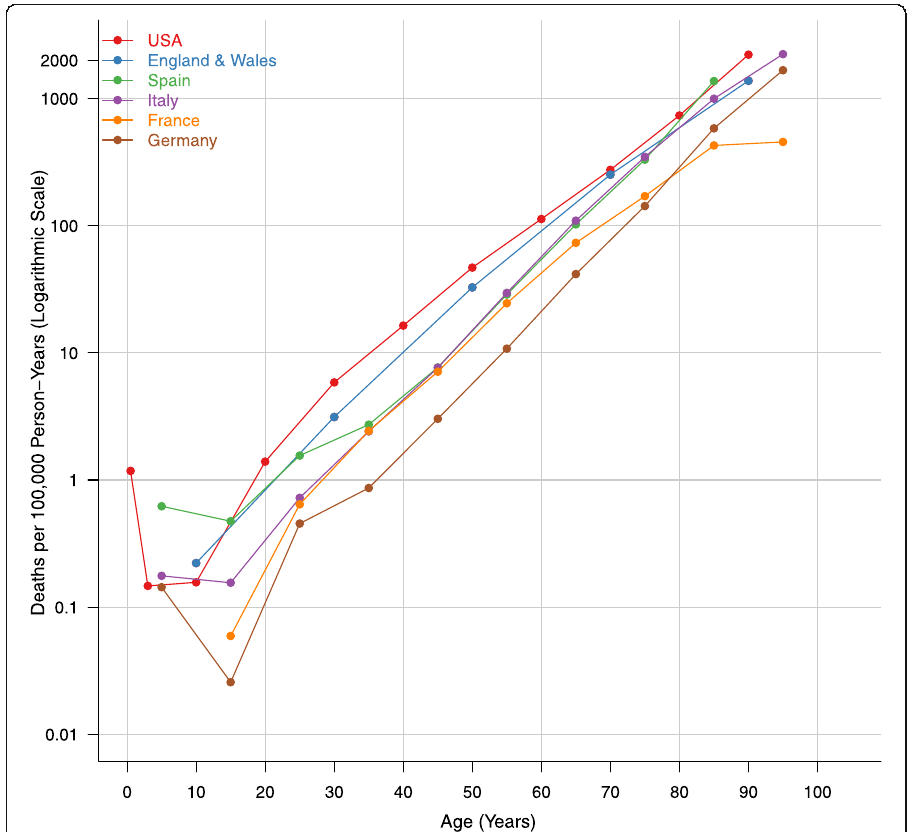
Fig. 1 Age-specific death rates from COVID-19 in England and Wales, France, Germany, Italy, Spain, and the US. Source: INED